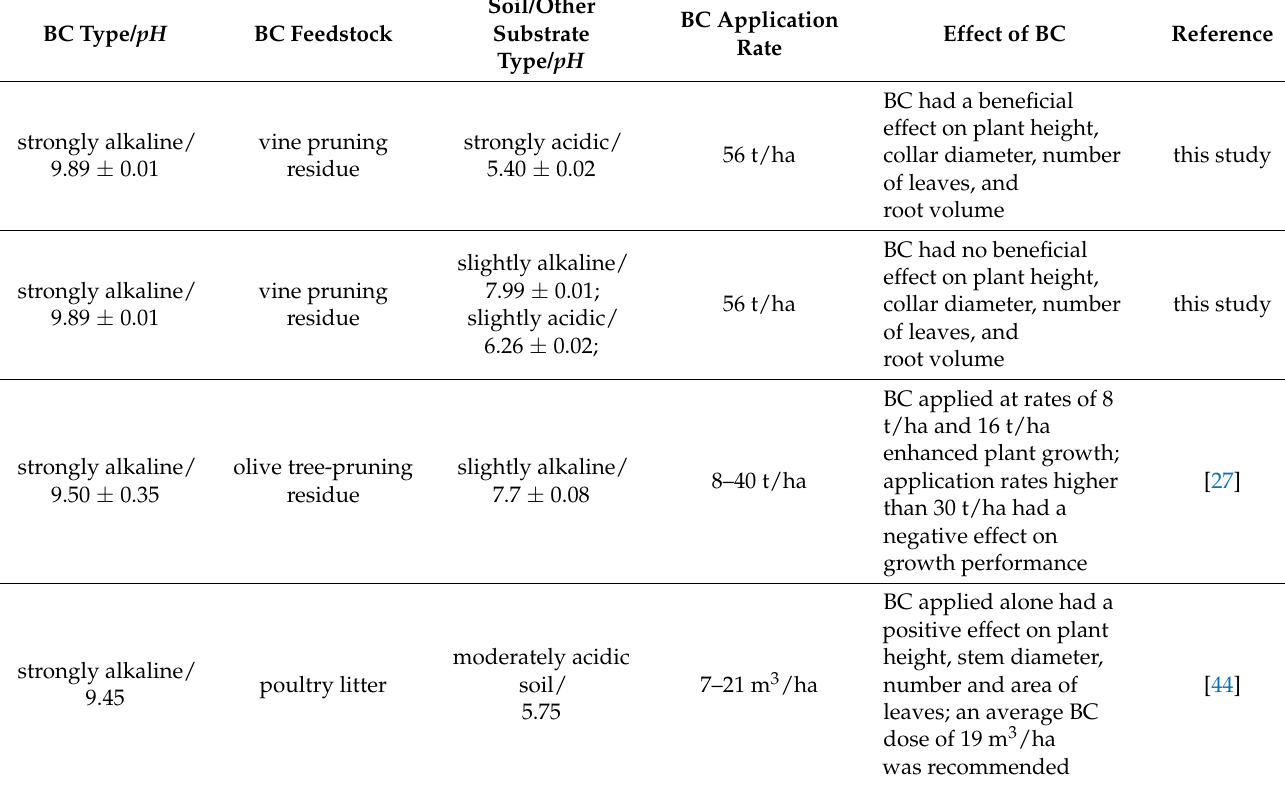
Table 6. Effects of BC on bell pepper growth and